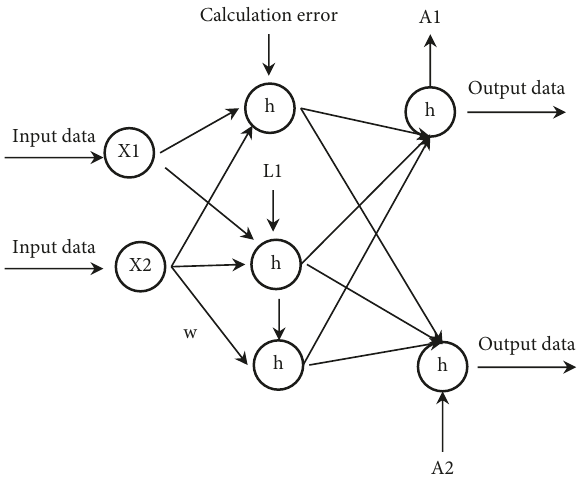
Figure 3: The operation flow of BP.